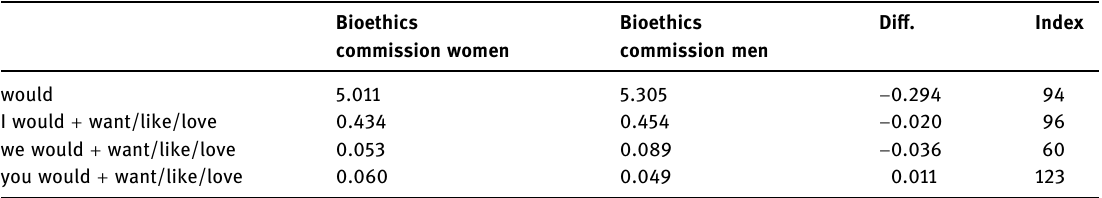
Table 9: Collocation of “ would ” with pronouns ( i/we/you ) and verbs of desire, as per cent of total tokens ( normalised, n = 1,000